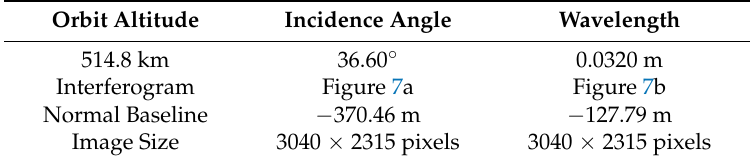
Table 3. Major parameters of the employed TerraSAR-X add-on for Digital Elevation Measurement (TanDEM-X)